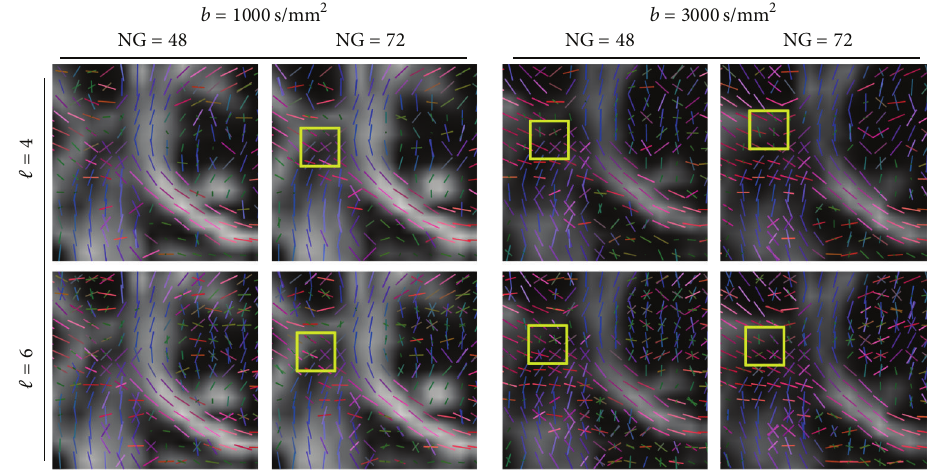
Figure 6: The effect of the truncation order of the spherical harmonics. The yellow rectangle marks the expected three-fold crossing of the CC, CR, and SLF. We observe more three-fold crossings at order ℓ = 3 . Additionally, 𝑏 = 3000 s / mm 2 performs better than 𝑏 = 1000 s / mm 2 , since more threefold crossings are recovered.